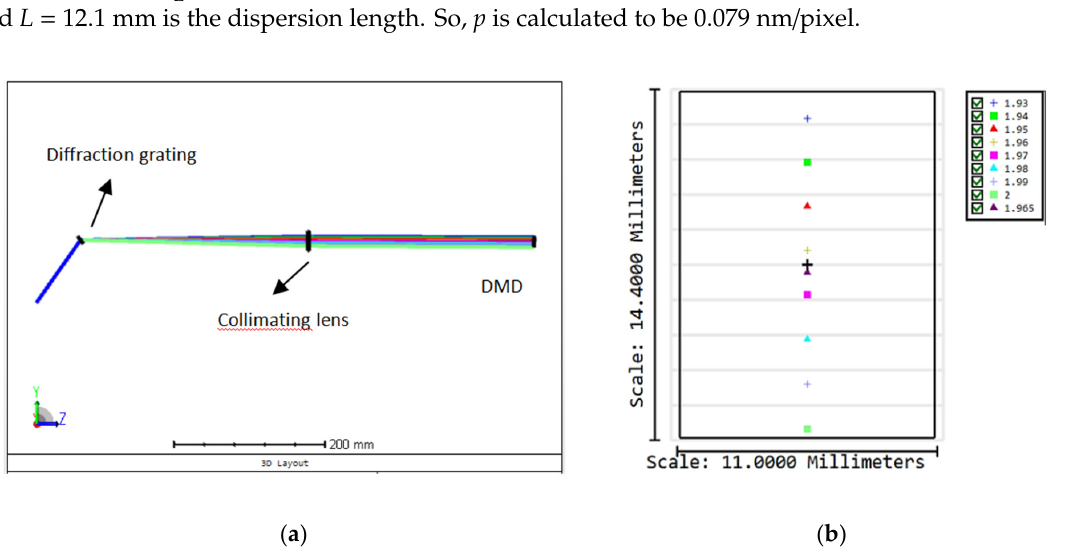
Figure 3. ( a ) Schematic diagram of light path in bulk optics and ( b ) dispersion spectrum of 1930–2000 nm on a 0.7” DMD.